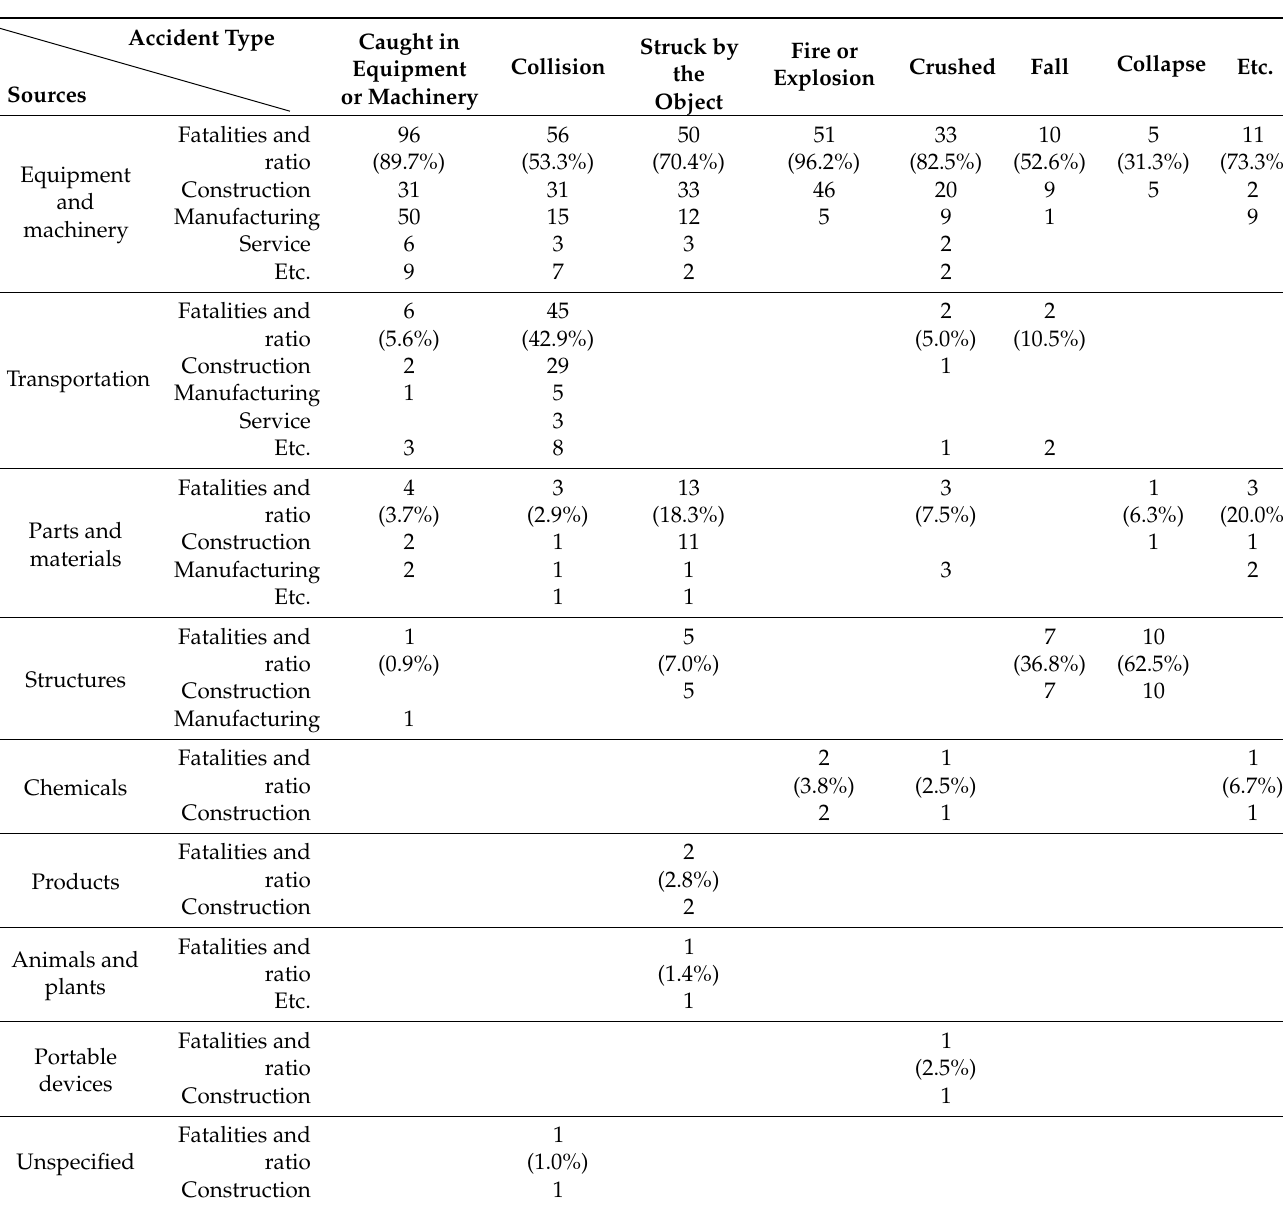
Table 8. Fatalities and ratio by sources of accident types due to multiple processes in the workplace based on